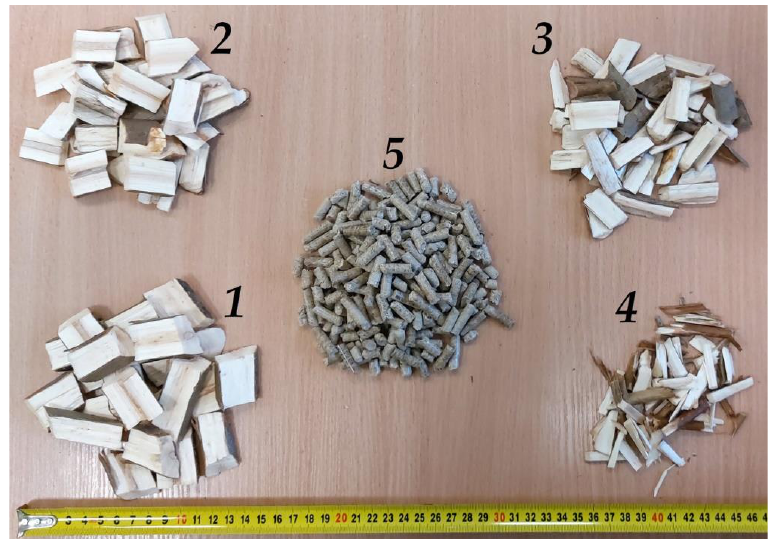
Figure 2. Fractional composition of the fuel from the biomass of a fast-growing willow Salix Vimi- nalis: 1 — a large fraction, 2 — a medium fraction, 3 — a small fraction, 4 — a very small fraction, and 5 — fuel pellets. A ratio of a full side area ( S ) to a fraction volume ( V ) of fuel — SVR [39] was used as a fuel parameter (Table 2). Table 2. Fuel fraction characteristics. Fraction